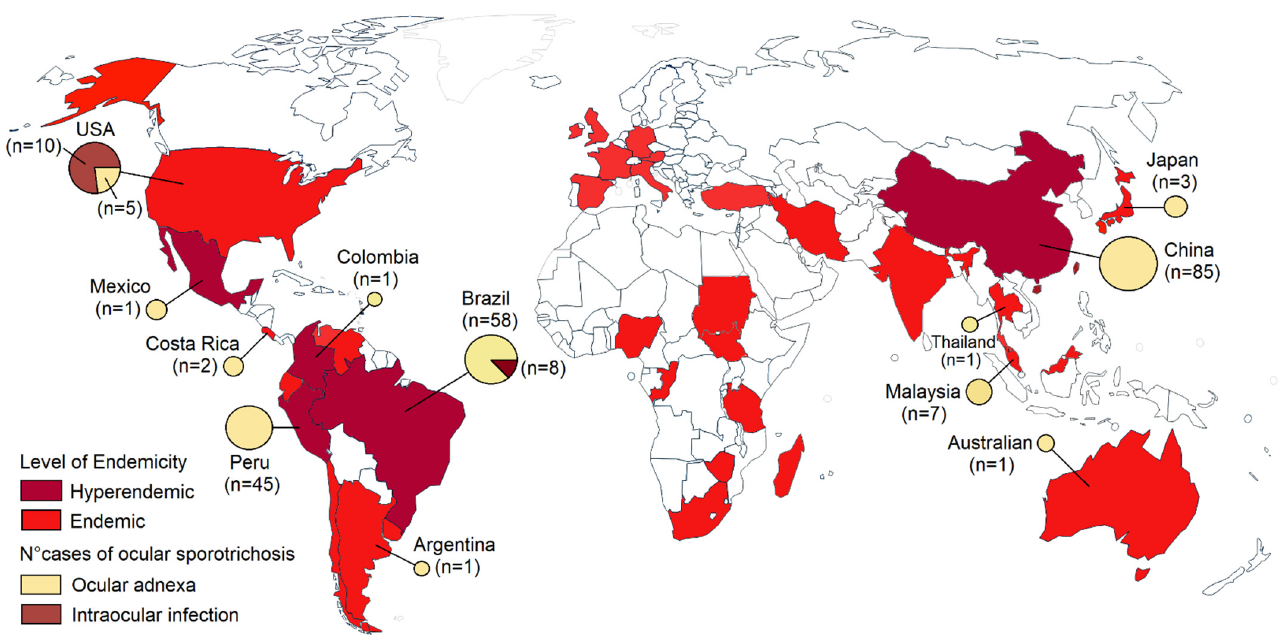
Figure 1. Map of the global distribution of sporotrichosis and cases of ocular sporotrichosis published in the literature. Infections are usually caused by S. schenckii , S. globosa , and S. brasiliensis . Rare patho- gens include S. pallida and S. mexicana . S. globosa causes about 99.3% of cases in Asia, 94% South and Central America and North America by S. schenckii [2,3]. All these species grow